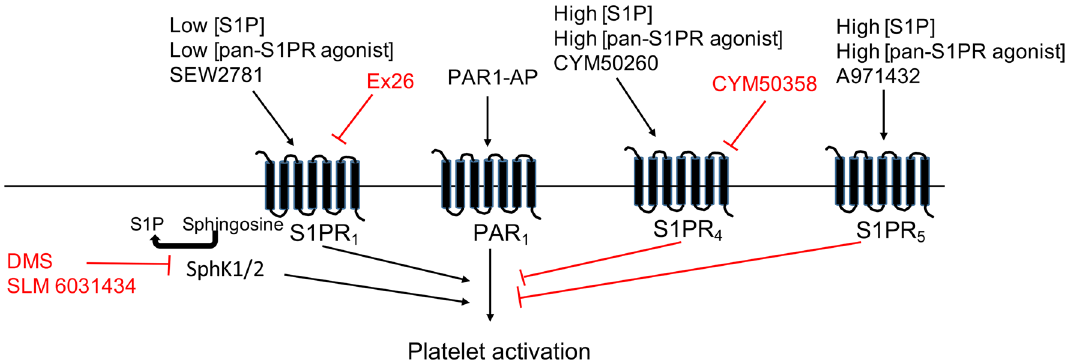
Figure 7. Summary of the biphasic modulation of platelets by S1P. Black arrows indicate activation, with red lines indicating